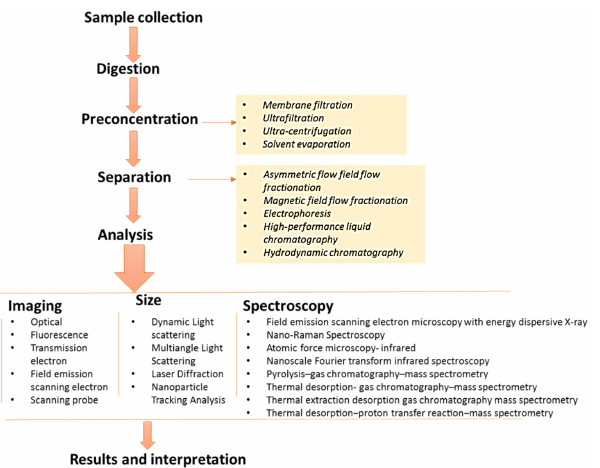
Figure 1. Analytical method framework for NPs analysis in environmental samples.